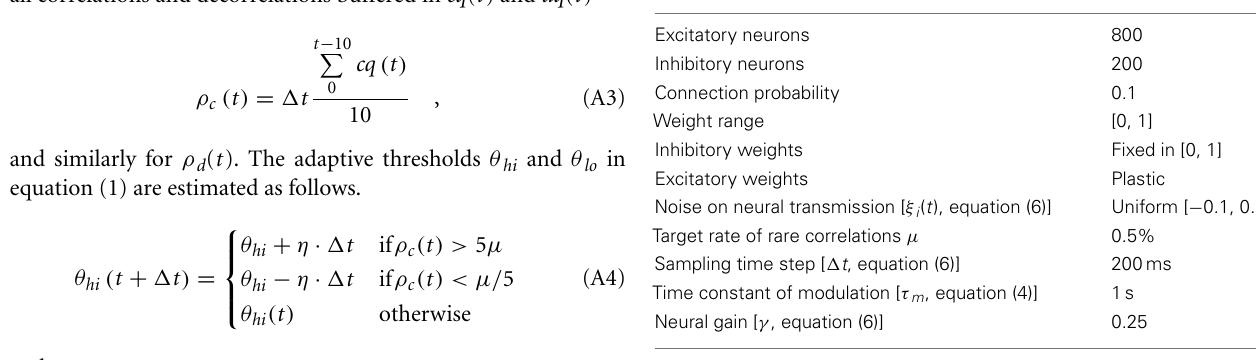
TableA2 | Parameters of the neural